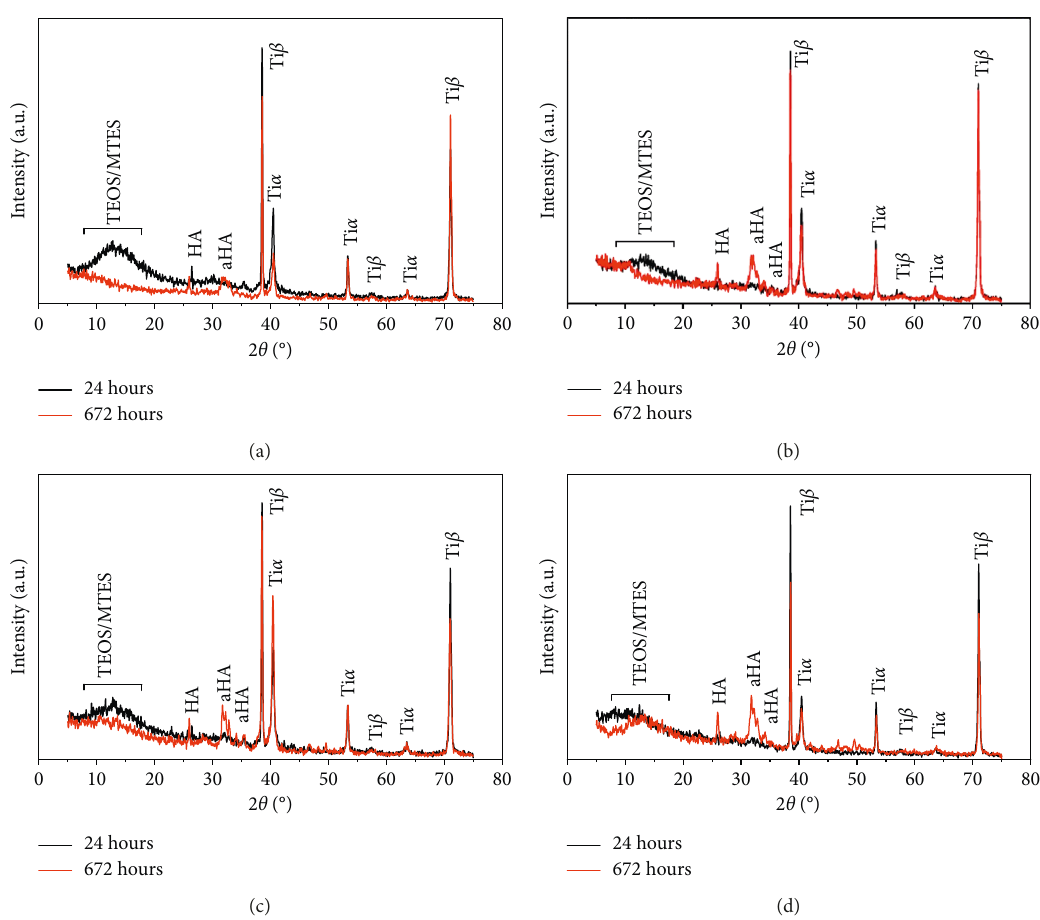
Figure 6: DRX of the coating before and after sterilization immersed for 24 and 672hours in SBF at 37 ± 3 ° C: (a) Ti6Al4V/TM/TM Ti6Al4V/TM/TM HA/OE , (c) Ti6Al4V/TM/TM HA/AC , and (d) Ti6Al4V/TM/TM HA/PH .